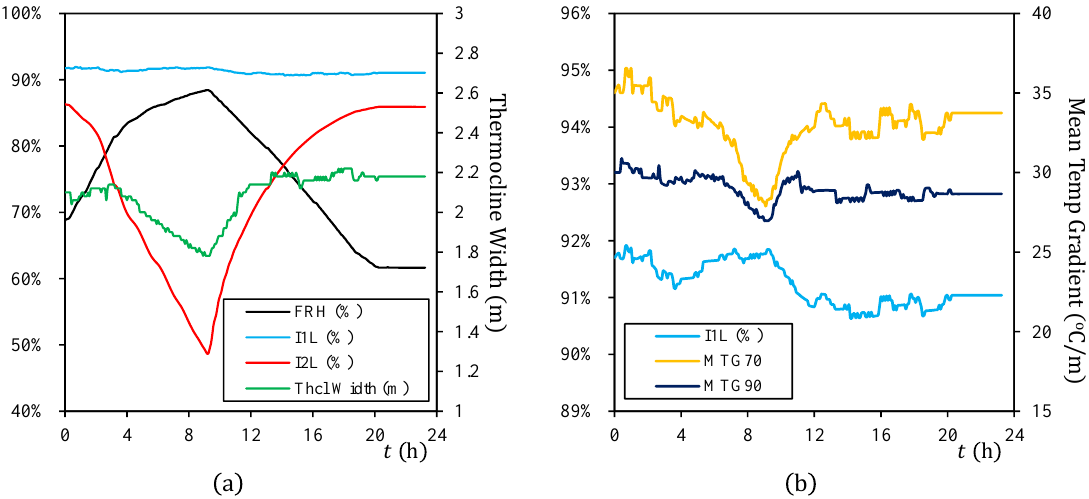
Figure 7. Results of: ( a ) FRH , I 1 L , I 2 L and thermocline width; ( b ) I 1 L , and Mean Temperature Gradients, for the 24 h period in Figure